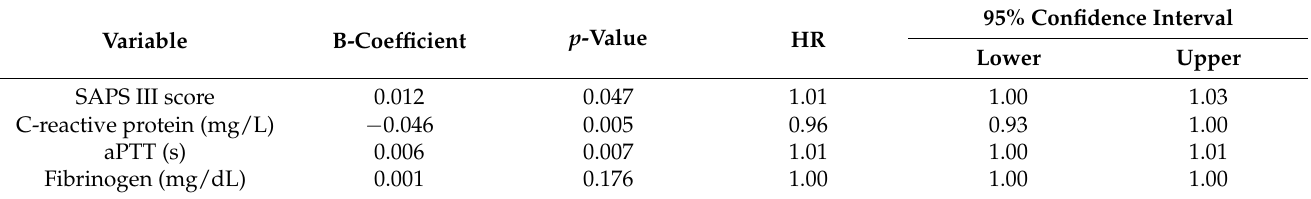
Table 4. Identification of risk factors for bleeding: Cox multivariate analysis ( n =